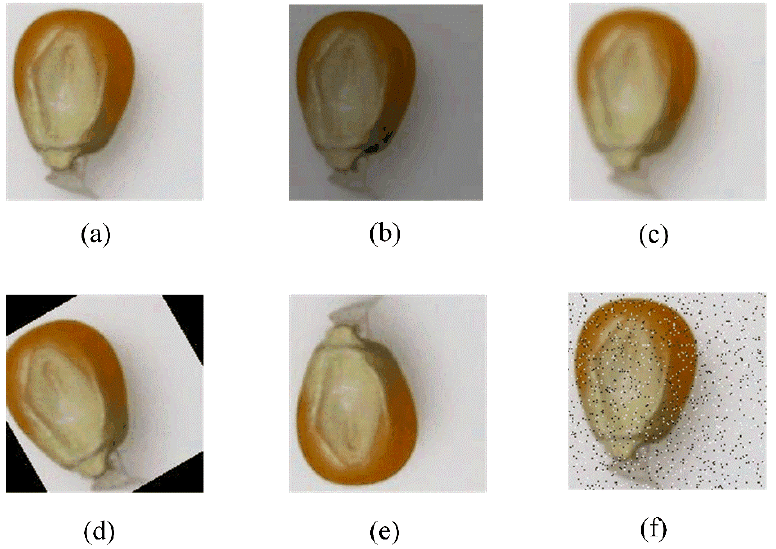
Figure 5. Image enhancement effect: ( a ) original image ( b ) Random brightness ( c ) Gaussian blur ( d ) Random rotation ( e ) Vertical rotation ( f ) Salt and pepper noise.